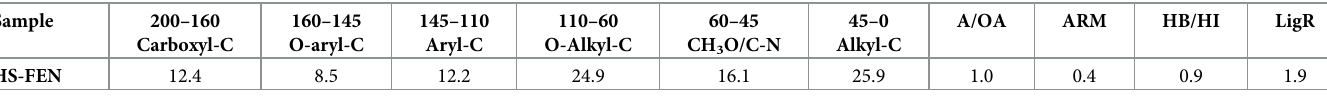
Table 1. Relative distribution (%) of signal areas over chemical shift regions (ppm) and structural indexes a in 13 C CPMAS-NMR spectrum of HS.